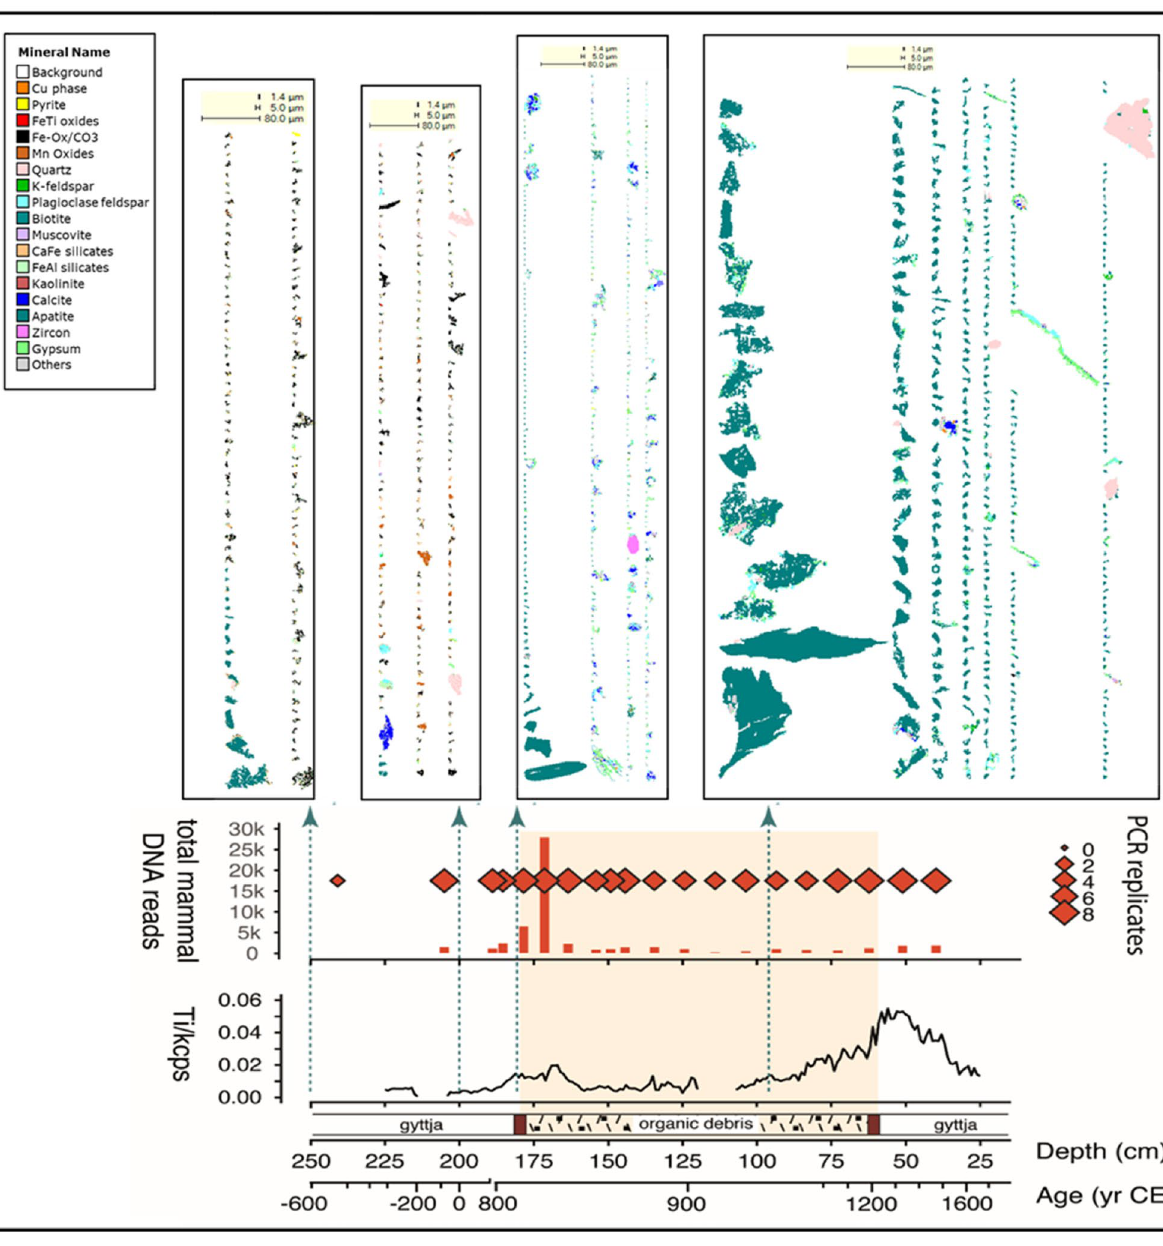
Figure 4. Core Ti and sedaDNA from the northern crannog with mineral grains determined by QEMSCAN at four depths in the core. Note all scale bars are 80